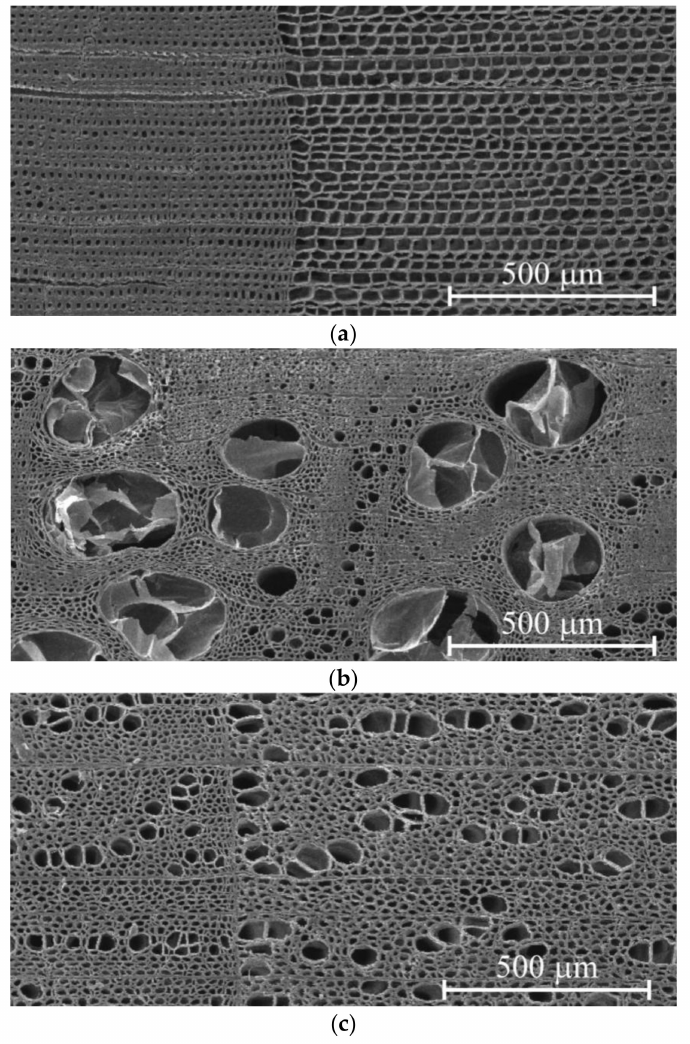
Figure 1. SEM images of crosscuts of common pine ( a ), pedunculate oak ( b ), and small-leaf lime ( c ) wood. The borders of growth rings are vertical and can be identified by an abrupt change of cells and a tracheid